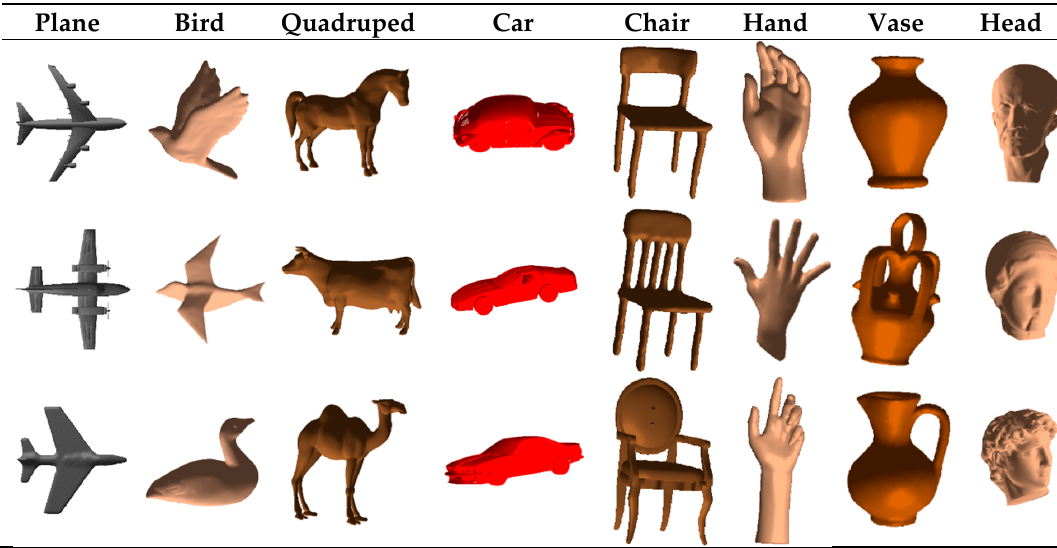
Figure 9. Objects used for experiments.